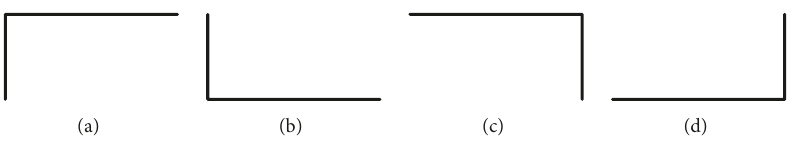
Figure 4: The basic lines of connection